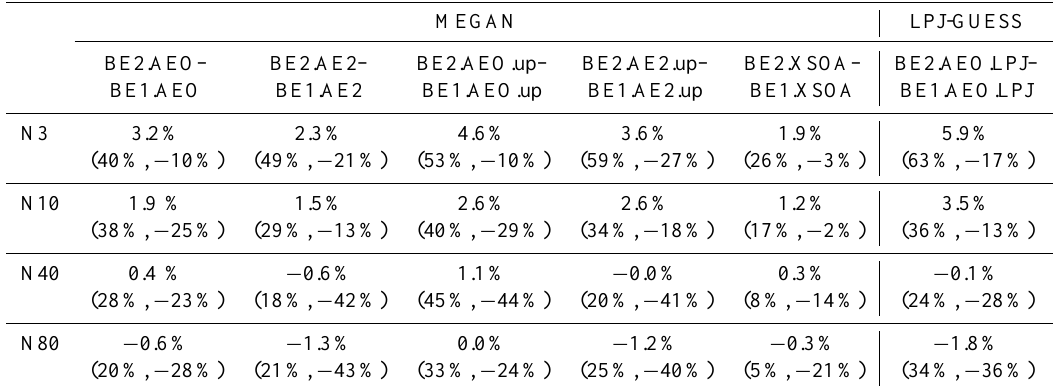
Table 2. Summary of global, annual mean percent changes in N3, N10, N40, and N80 (number of particles with diameter greater than 3, 10, 40, and 80nm, respectively) when changing BVOC emissions from year 1000 to year 2000 using the MEGAN and LPJ-GUESS reconstructions. The values in brackets are the global maximum and minimum percent changes.